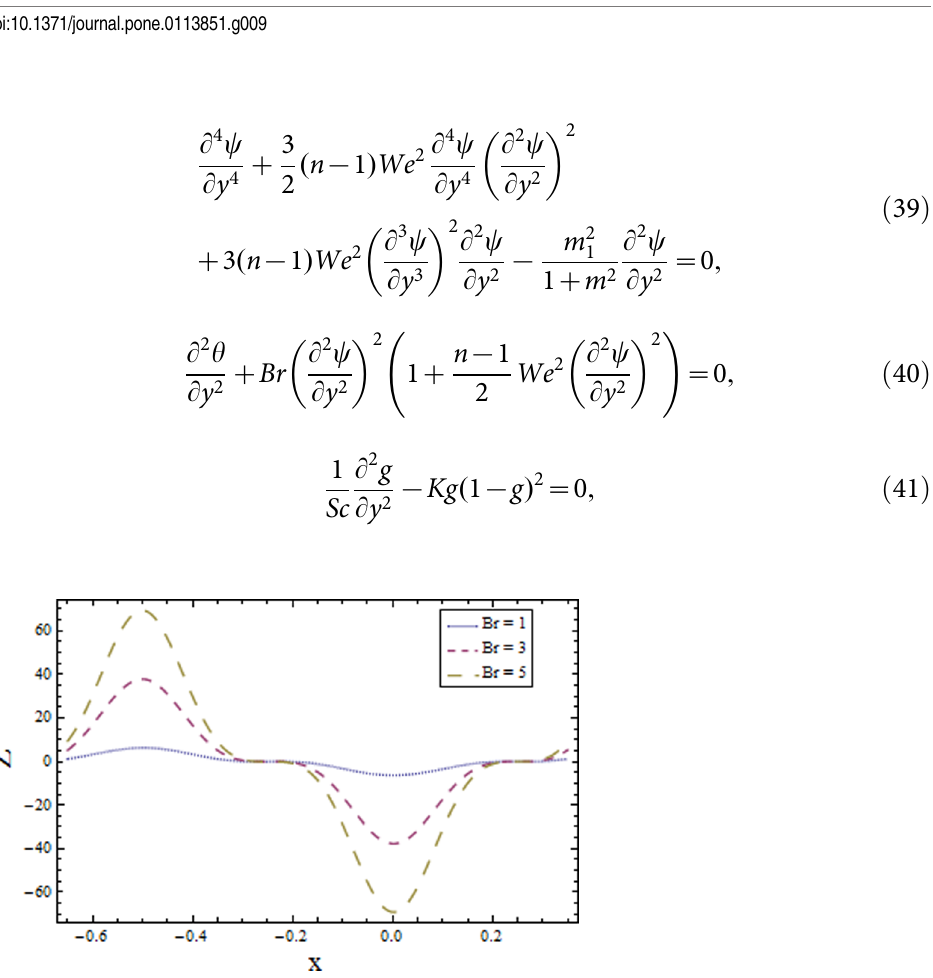
Figure 10. Plot of heat transfer coefficient Z for Brinkman number Br with E ~ 0 : 1 , t ~ 0 : 01 , ª 1 ~ 4 , ª 2 ~ 6 ,